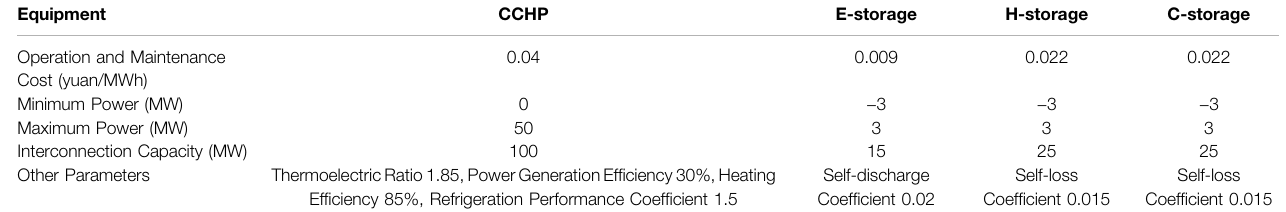
TABLE 3 | Basic performance parameters of the equipment.